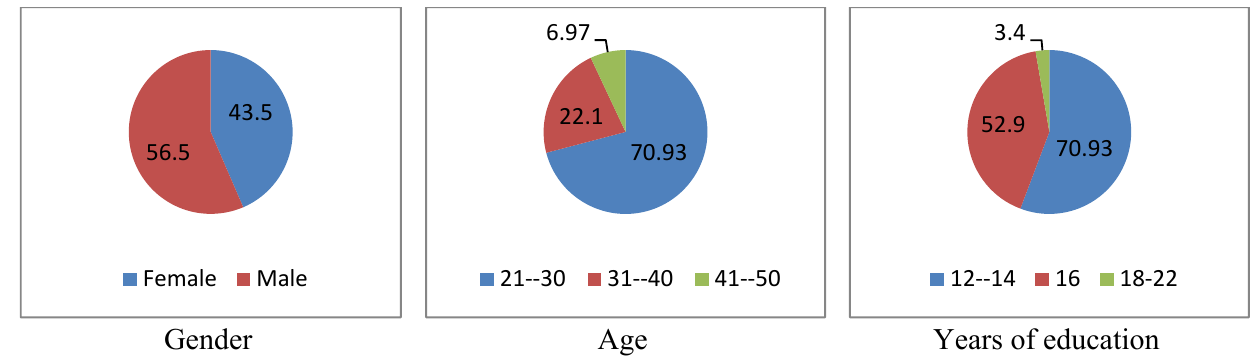
Fig. 1. Personal characteristics of the participants